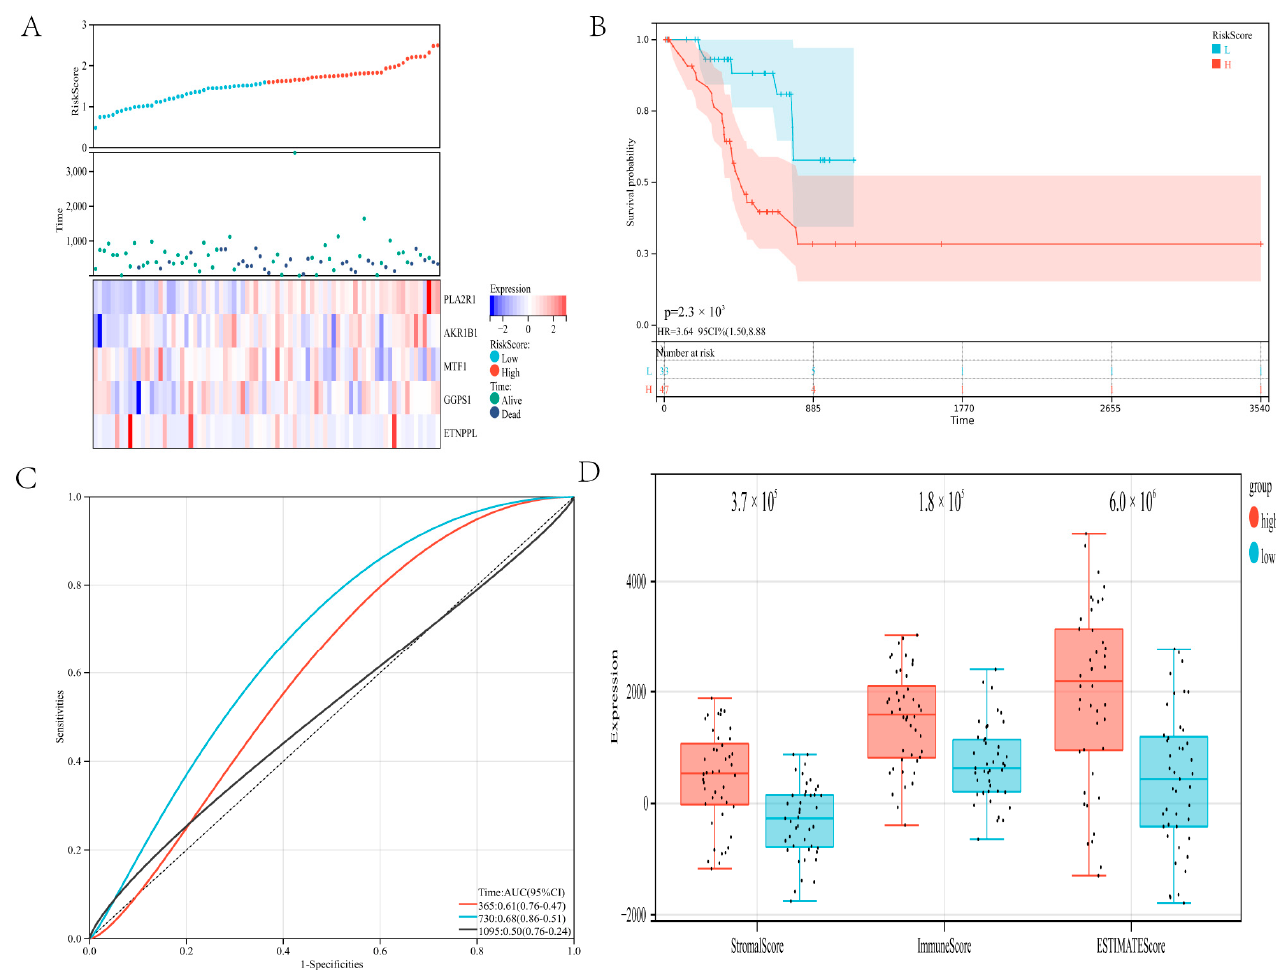
Figure 7. Validate the risk model: ( A ) Show survival status and the expression of five genes in the validation cohort. ( B ) In the verification cohort, the survival curves of patients in the high-risk and low-risk groups. ( C ) ROC curve of the risk model in the verification cohort. ( D ) The ESTIMATE algorithm evaluated the immune scores of the two groups of gastric cancer patients in the verification cohort.